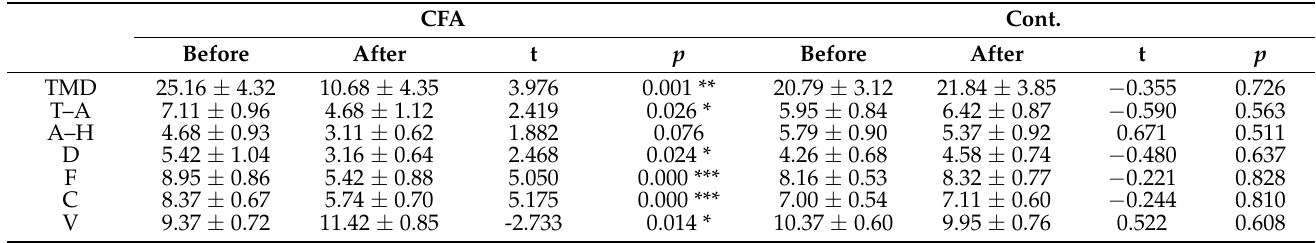
Table 2. The results of paired t-test analyses of subjective Profile of Mood State (POMS) scores. CFA Cont. Before After t p Before After t p TMD